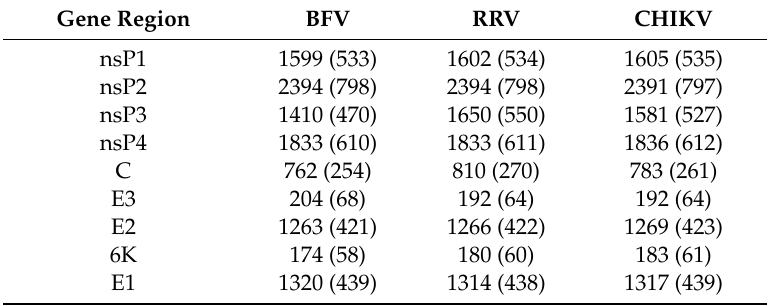
Table 2. Comparisons of gene region nucleotide sequence (and amino acid sequence in